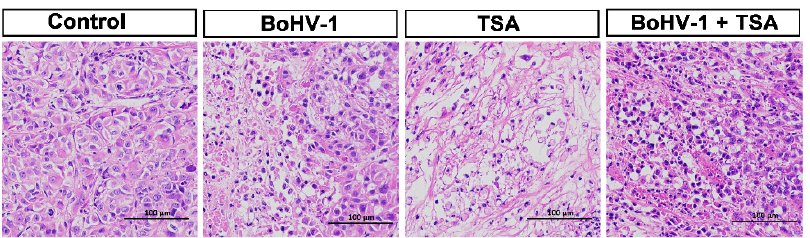
Figure 6. The evaluation of BoHV-1 antitumor effects by using histological analysis. The mice were either mock treated with PBS control, or treated with BoHV-1, TSA, as well as BoHV-1 and TSA combination. Tumor sections from each group were subjected to H&E staining. Images shown were represents of one mouse in each group.